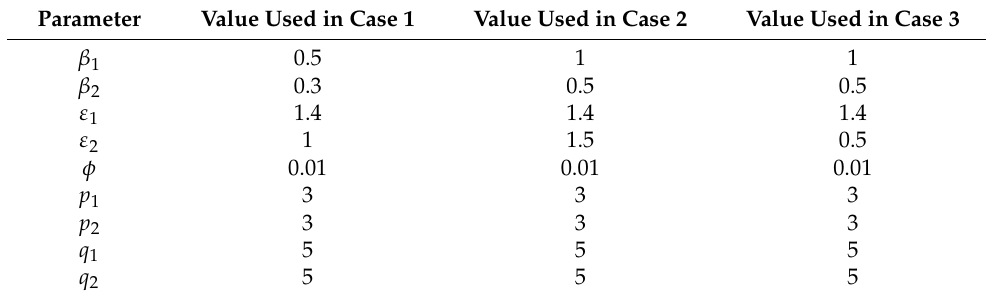
Table 2. Controller parameters for the straight-line trajectory. Parameter Value Used in Case 1 Value Used in Case 2 Value Used in Case